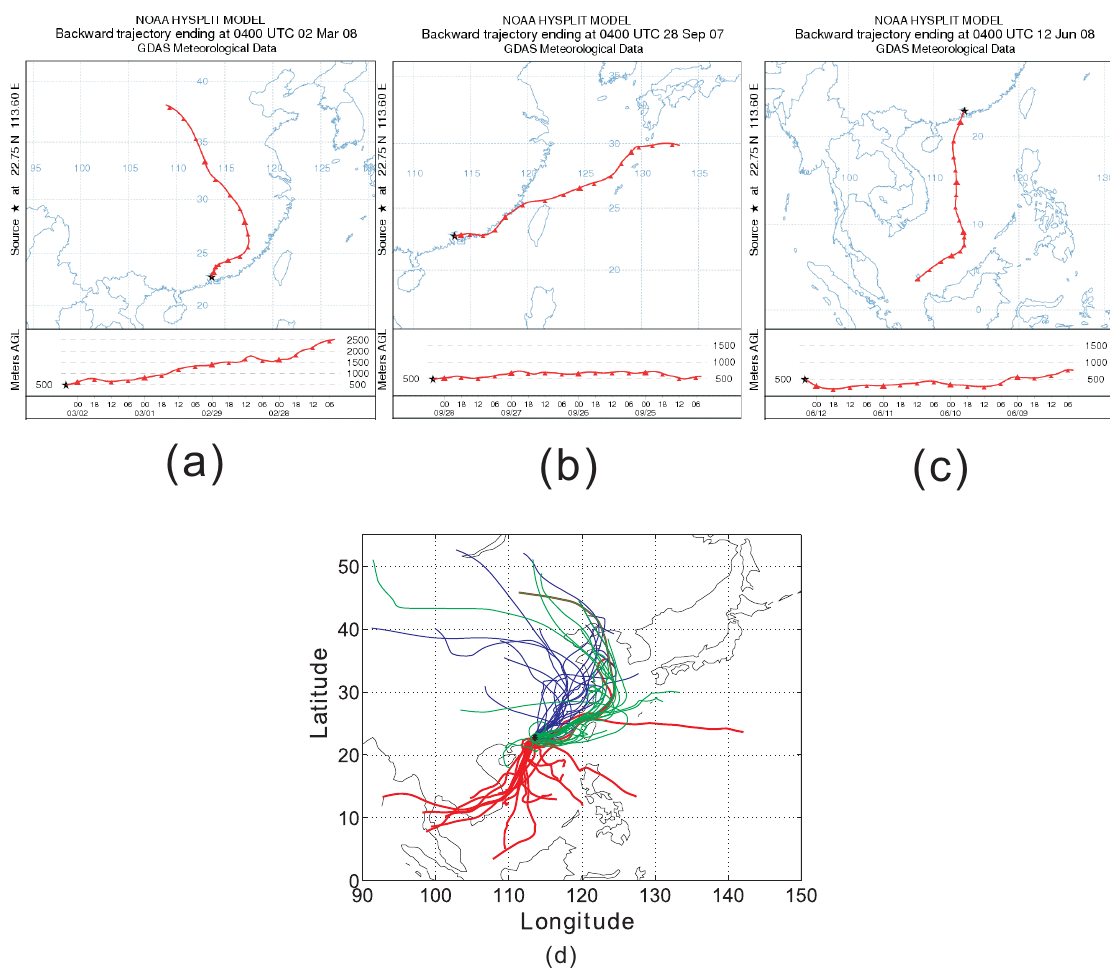
Fig. 3. Three examples of typical 96-h air mass back trajectories representing three types of air mass origin: (a) continental, (b) transition, and (c) marine. Panel (d) shows air mass trajectories of all the sampling days, with lines in blue, red, and green denoting air mass trajectories of continental, marine, and transitional origins,